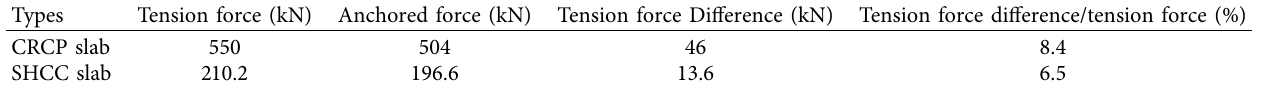
Table 9: Comparison of anchor forces between CRCP slab [18] and SHCC slab.